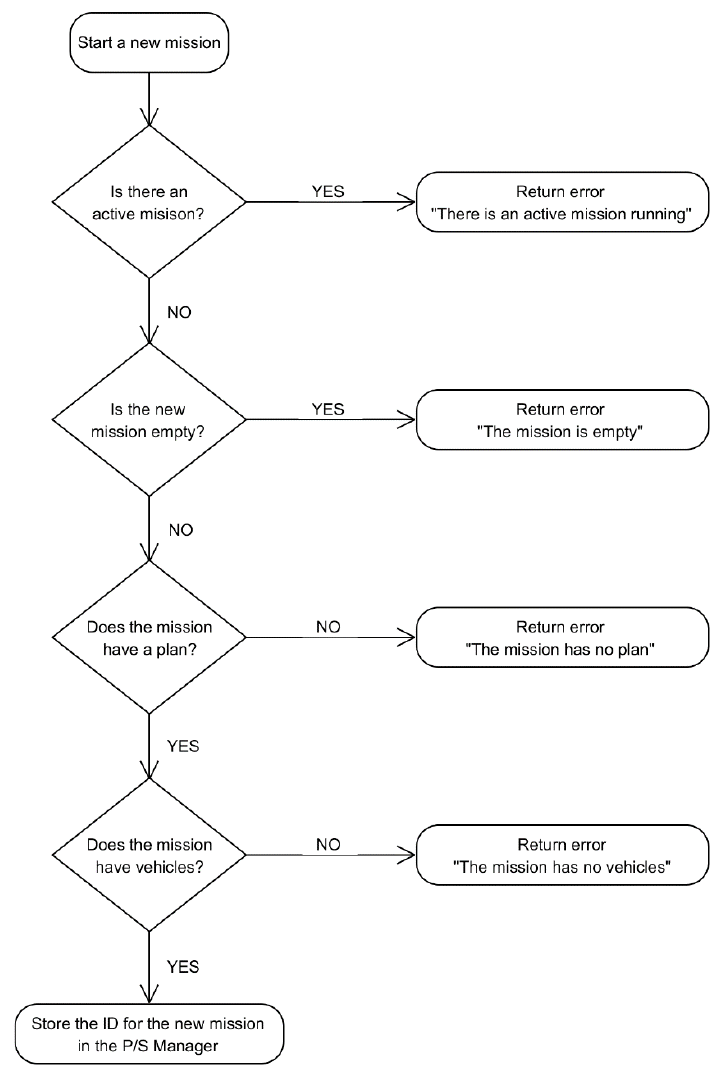
Figure 10. Flow diagram for the plan validation undertaken at the MTRR.